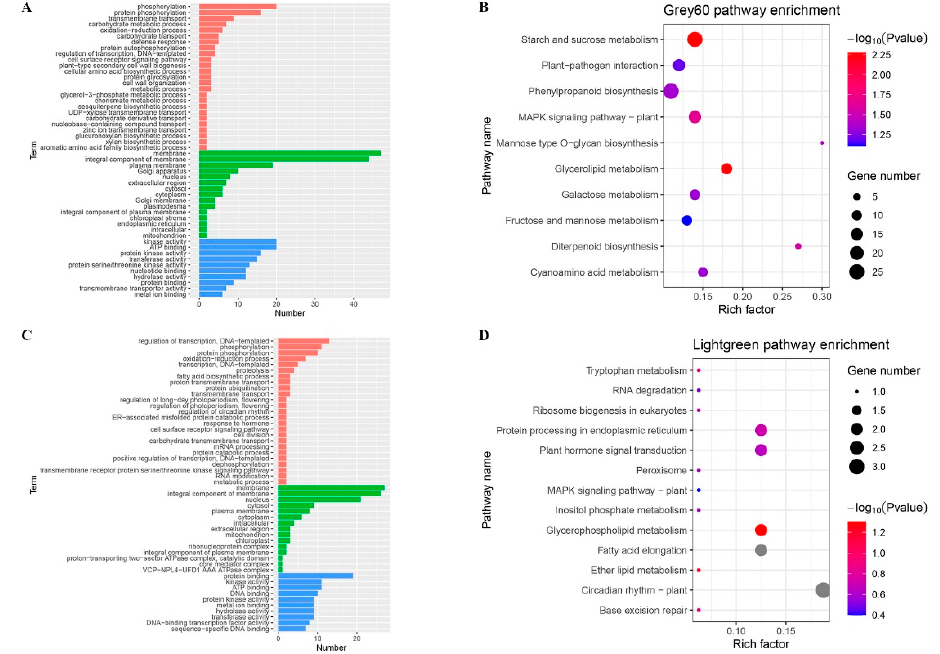
Figure 7. The functional analysis of genes in the phenotypic significant enrichment module. ( A ) GO analysis of differential genes in grey60 module (Red indicates biological process; green indicates cellular component; blue indicates molecular function); ( B ) significant pathway enrichment analysis in grey60 module; ( C ) GO analysis of differential genes in the light green module; ( D ) significant pathway enrichment analysis in the light green module.